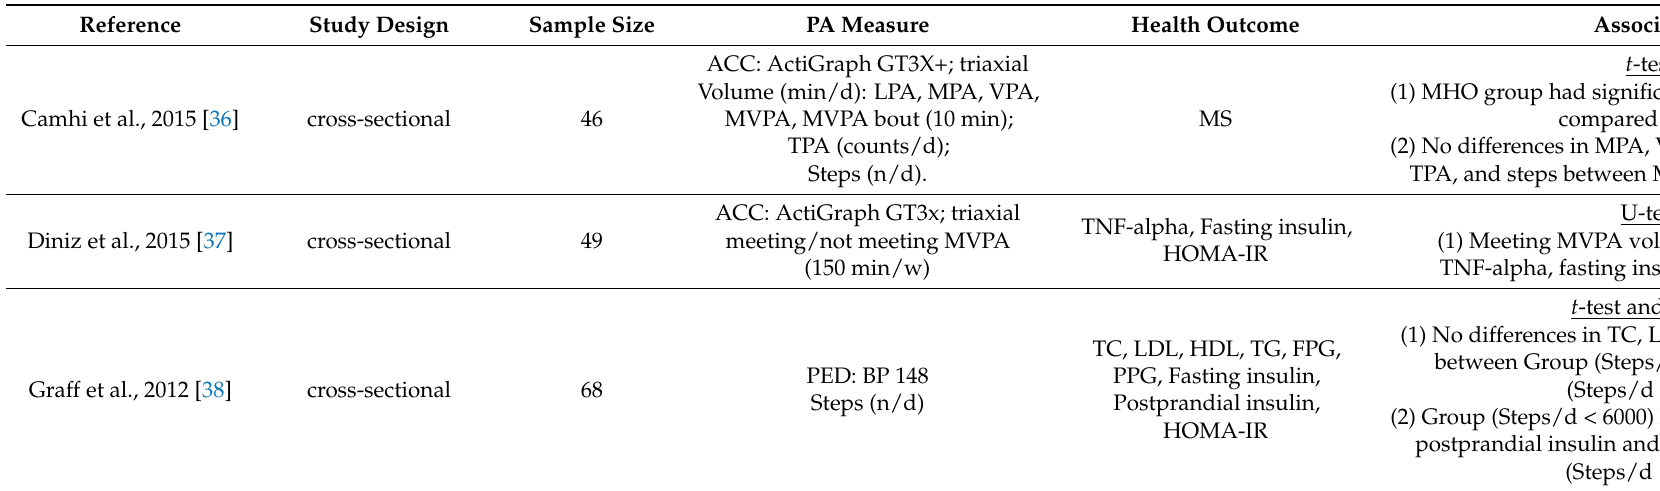
Table 1. Characteristics of observational